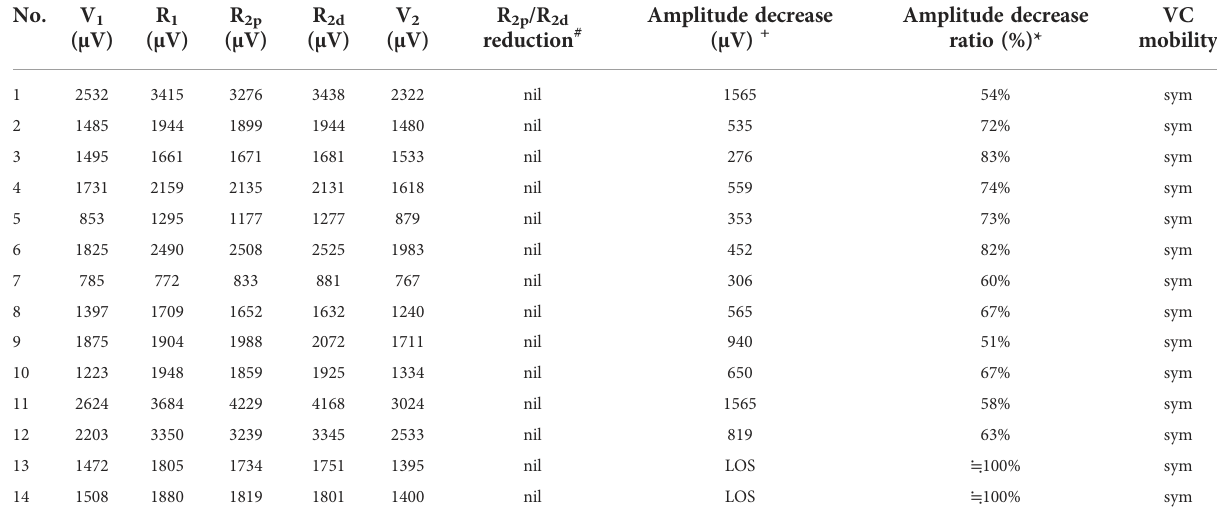
TABLE 1 Type A EMG recovery pattern (complete EMG